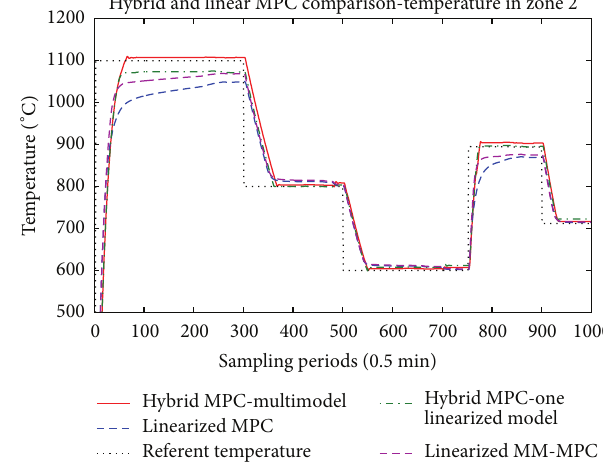
Figure 6: Temperature in the second zone.